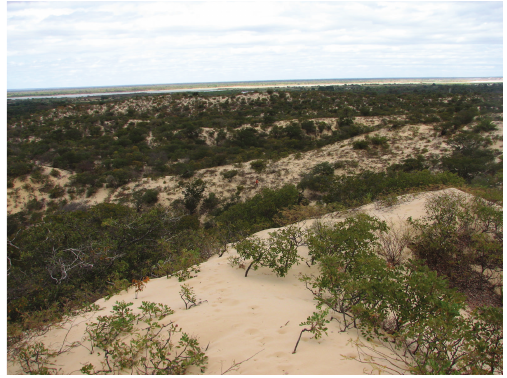
Figure 1: Picture from the sand dunes of the middle S˜ao Francisco